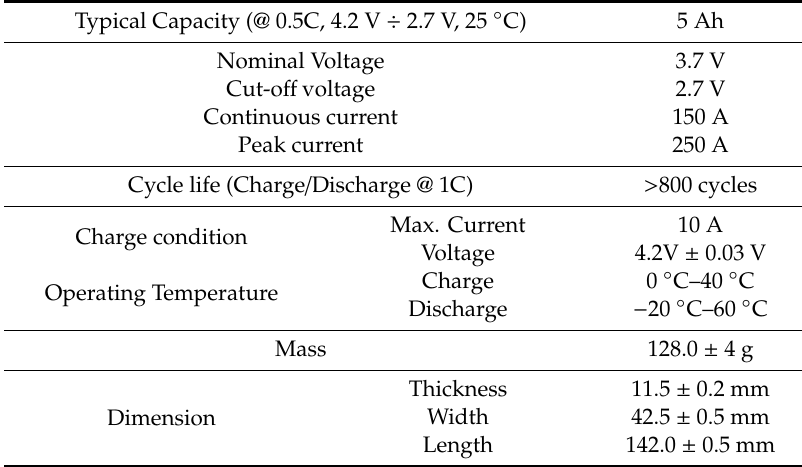
Table 1. Main characteristics of the cell KOKAM SLPB